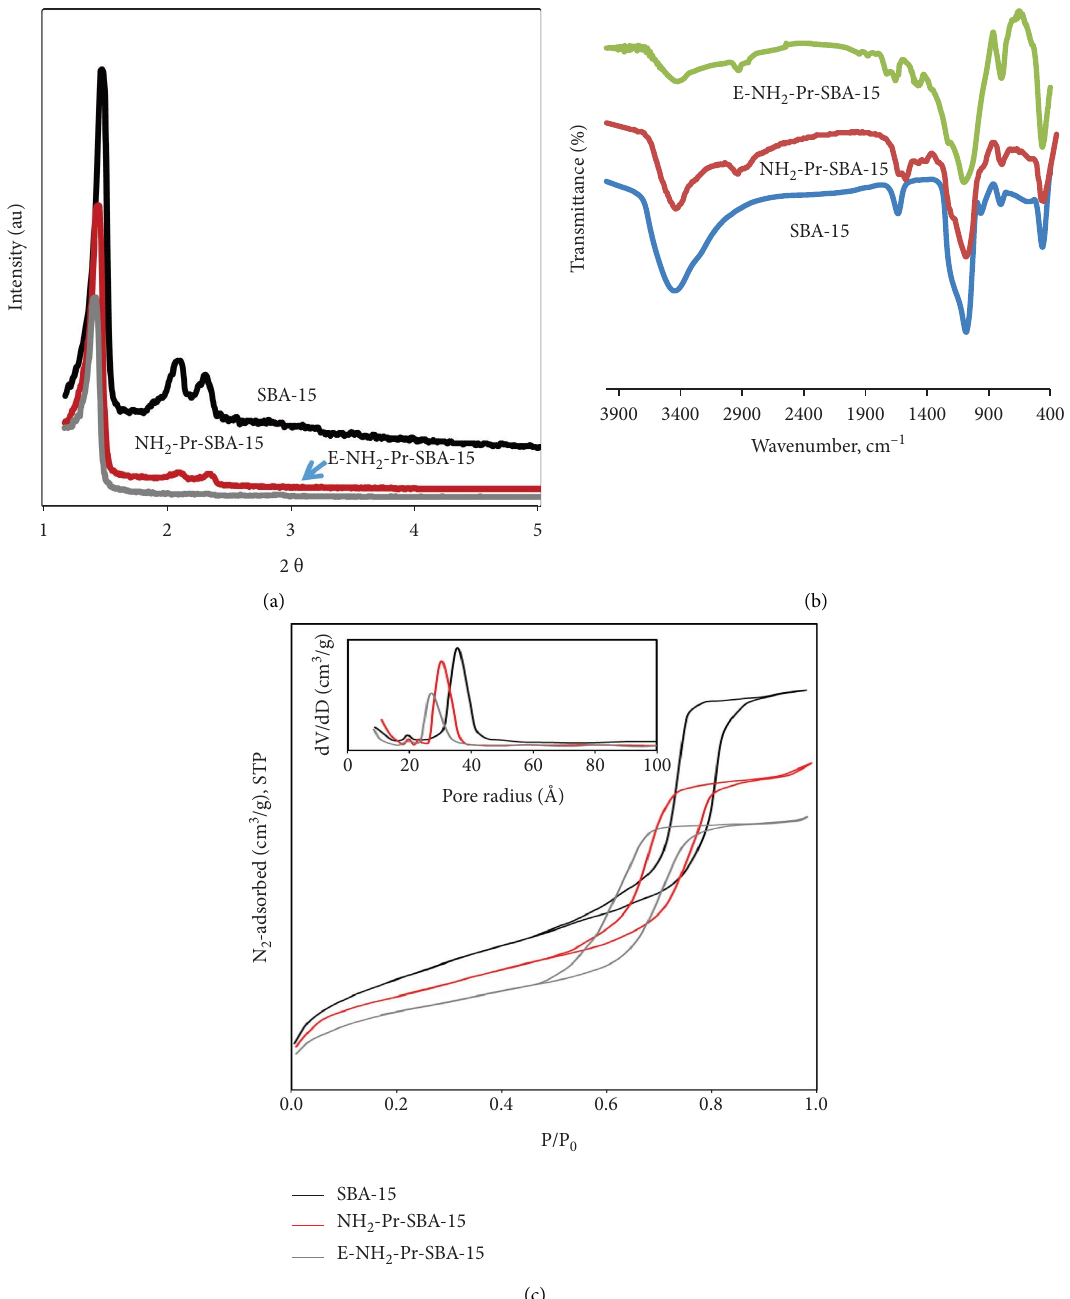
Figure 4: Te XRD (a), FTIR (b), and N 2 adsorption/desorption isotherms and pore diameter distribution (c) of the prepared